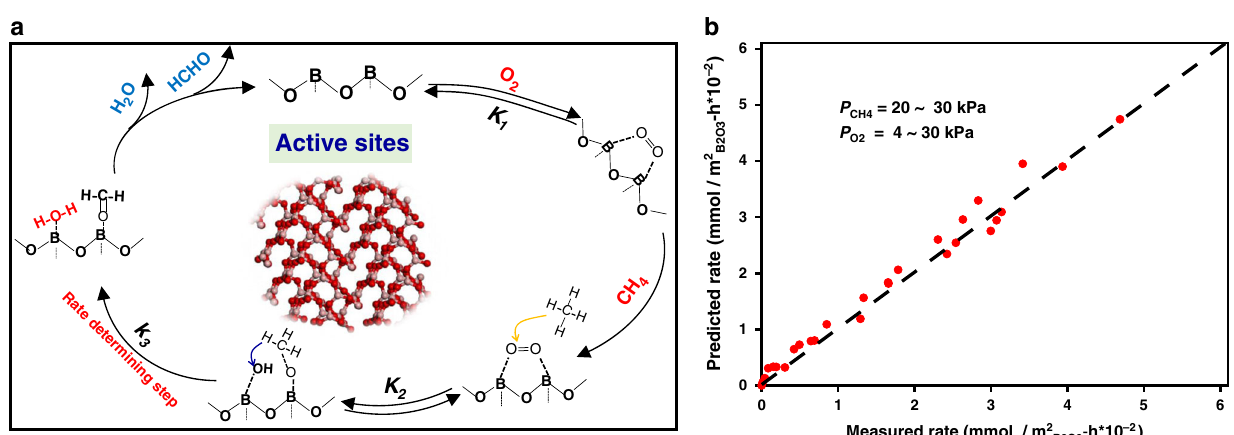
Fig. 4 Mechanistic insights for methane activation on a B 2 O 3 surface. a Schematic diagram of the plausible pathway of methane selective oxidation to formaldehyde on B 2 O 3 -based catalysts. b Parity plots for the measured rate data of methane selective oxidation on B 2 O 3 /Al 2 O 3 and those predicted using Eq. 1 (the regression- fi tted parameters shown in Supplementary Table 3). In a , K 1 and K 2 are equilibrium constants for the corresponding steps, and k 3 is the kinetic constant for hydrogen abstraction of the surface methoxy species by a